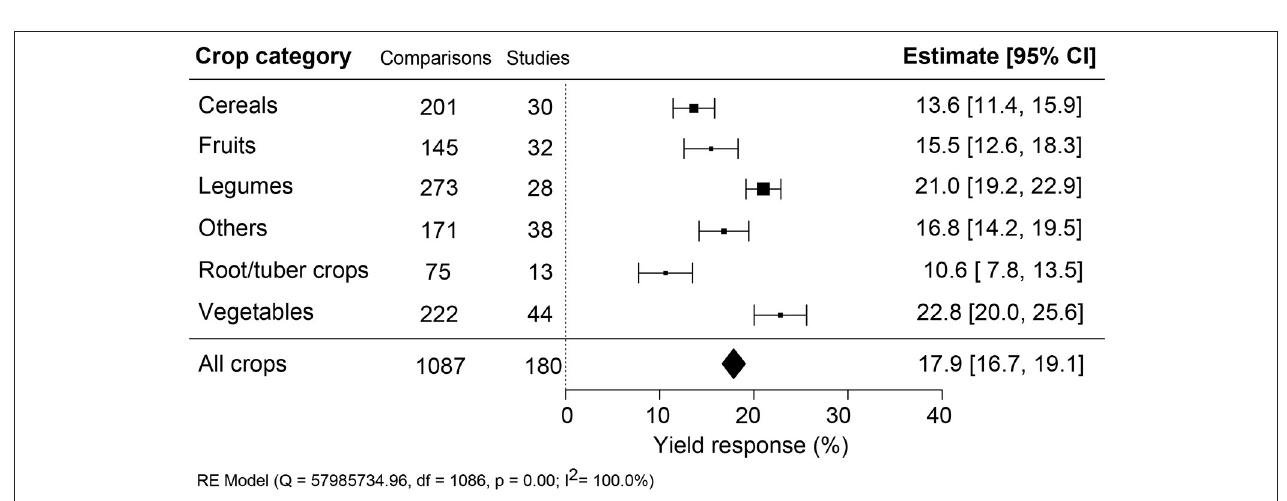
FIGURE 4 | Percentage yield response to biostimulant application affected by the crop categories. The point size correlates to the estimate’s precision, and the error bars represent 95% confidence intervals (CI) of mean estimated effect sizes. The number of comparisons and studies is indicated in each line. The combined effect estimates and the heterogeneity test on the random-effect model (RE) were summarized at the bottom, where the heterogeneity test is significant ( p < 0.001) and I 2 ≥ 75% implies substantial